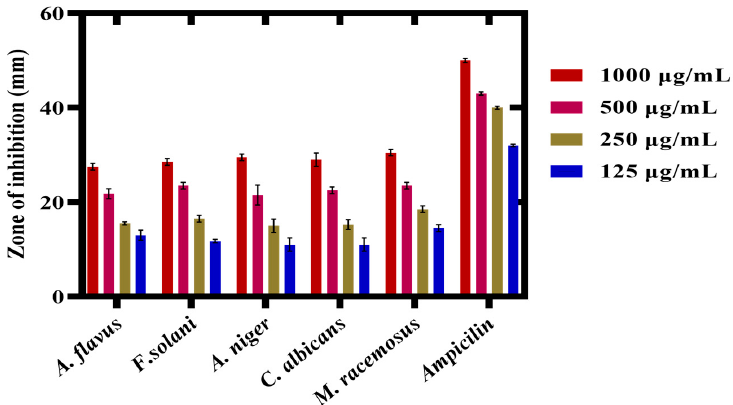
Figure 12. Antifungal potential of biogenic Ag 2 ONPs .